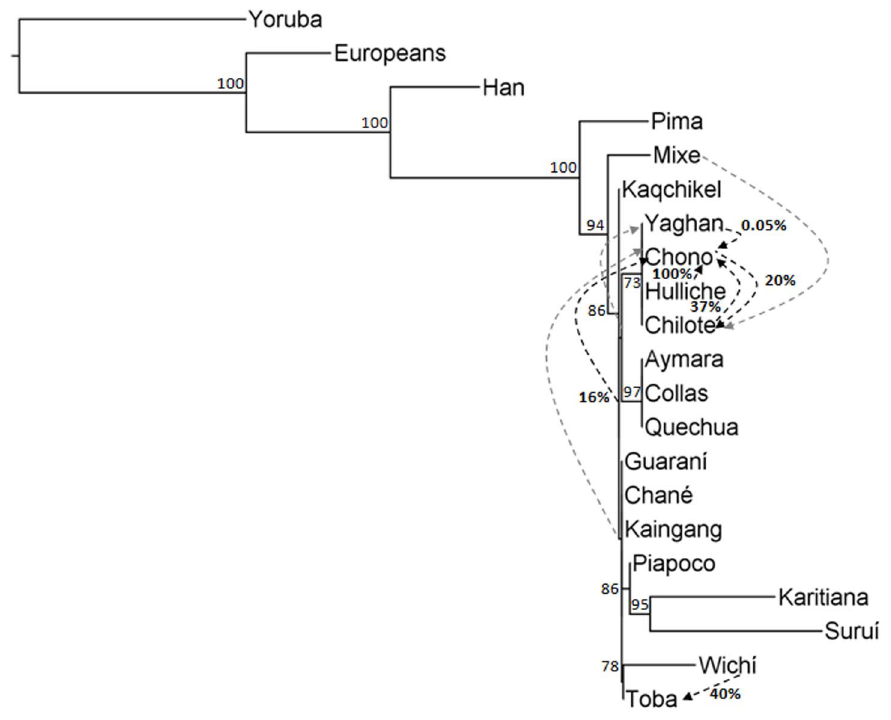
Figure 3. Consensus maximum likelihood tree for a reduced number of populations with 10 migration events. Non-bold numbers are bootstrap estimates based on 100 iterations with a support greater than 70%. Quechua, Aymara and Collas form one clade and group with Chilean Andean speakers (Yaghan, Hulliche, Chono and Chilote). Gran Chaco populations (Toba, Wichı´, Guaranı´, Chane´ and Kaingang) form a clade with Brazilians (Suruı´ and Karitiana) and Colombians (Piapoco). Mixe and Pima from Mexico cluster outside all South Americans and Kaqchikel from Guatemala. Branch length refers to the amount of drift experienced but is also increased in populations with more individuals in the data set. Black arrows indicate migrations confirmed as significant by f 4 test, while grey arrows indicate insignificant f 4 results. Bold numbers represent admixture proportions for black arrows: Toba received 40% admixture proportion from Wichı´. Gene flow among Chilean Andeans was strongly supported: Hulliche contributed 100% admixture to Chono and HA Andeans 16%. An ancestral population of Chilote and Chono contributed 37% to Chono and 20% to Chilote. Yaghan contributed 0.05% admixture proportion to Chono.